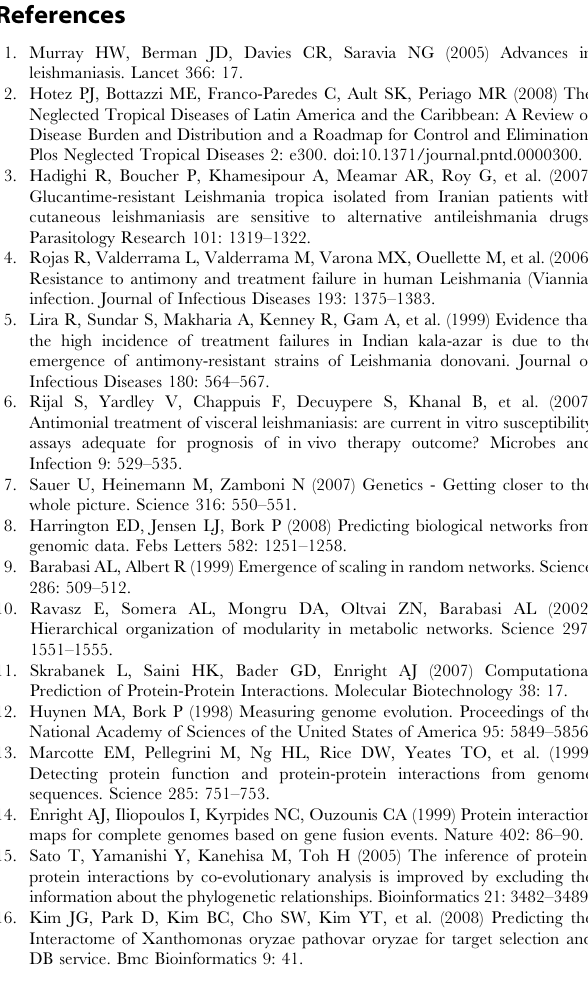
Table S7 Annotation of hypothetical proteins. Predicted annotation based on FS-Weight and GO ontology assigned to hypothetical proteins present in the